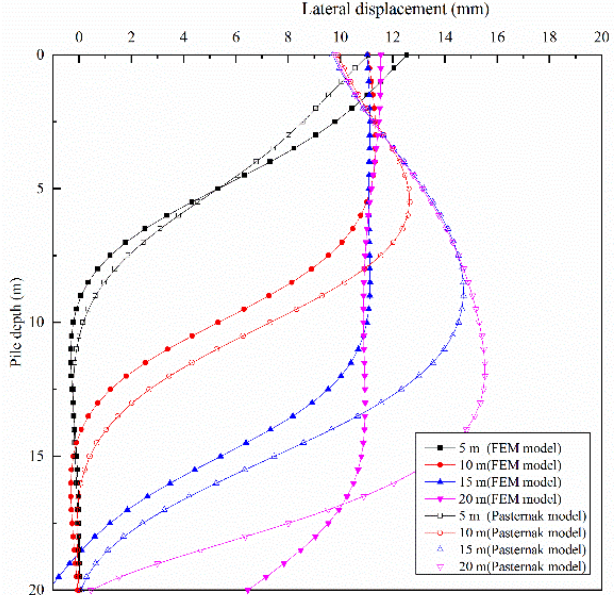
Figure 12. Comparison of calculation results between numerical simulation and Pasternak foundation model with pile tip fixed.